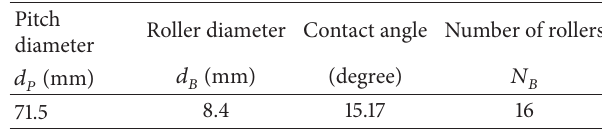
Table 3: Geometric parameters of the roller bearing.